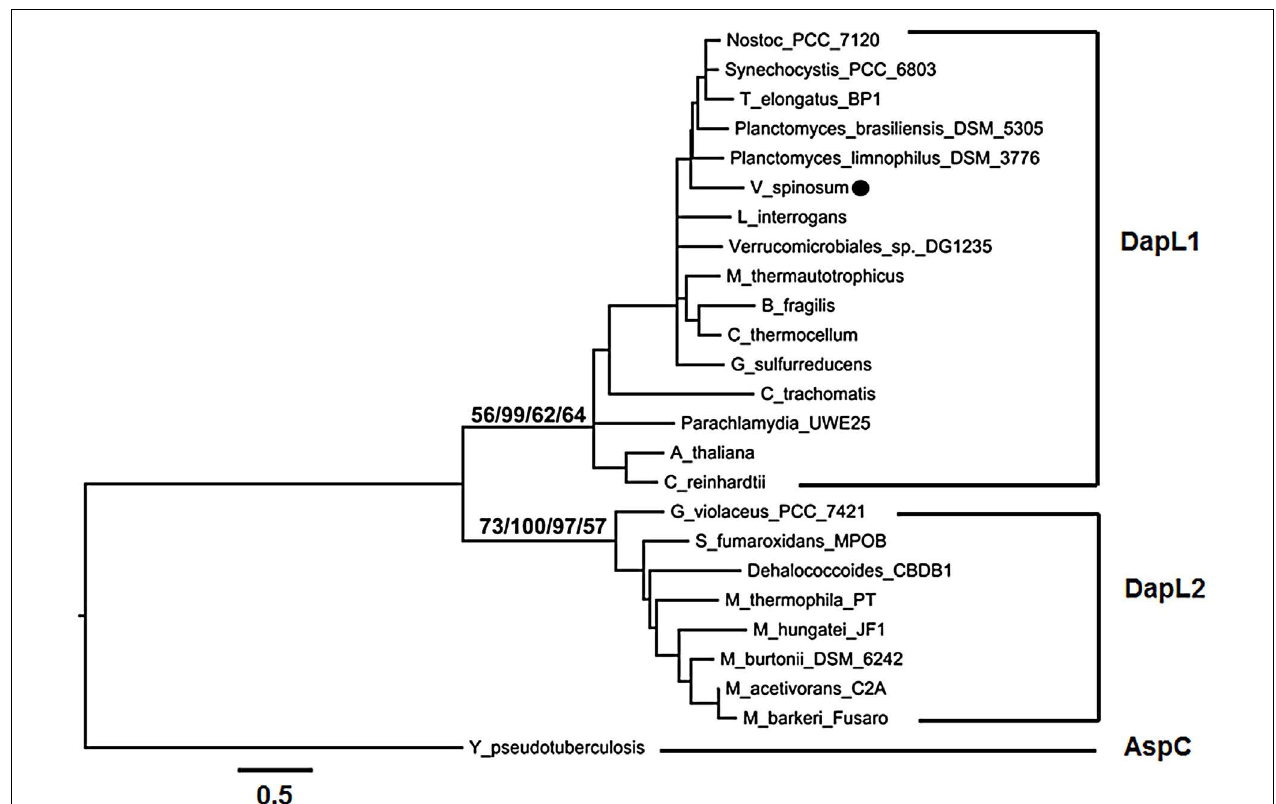
Branch lengths are proportional to divergence; the scale below the tree indicates percent divergence of the branch lengths.The tree was rooted with a single outgroup aspartate aminotransferase (AspC) from Y. pseudotuberculosis . Figure drawing produced using FigTree (ver. 1.6.1; Rambaut,